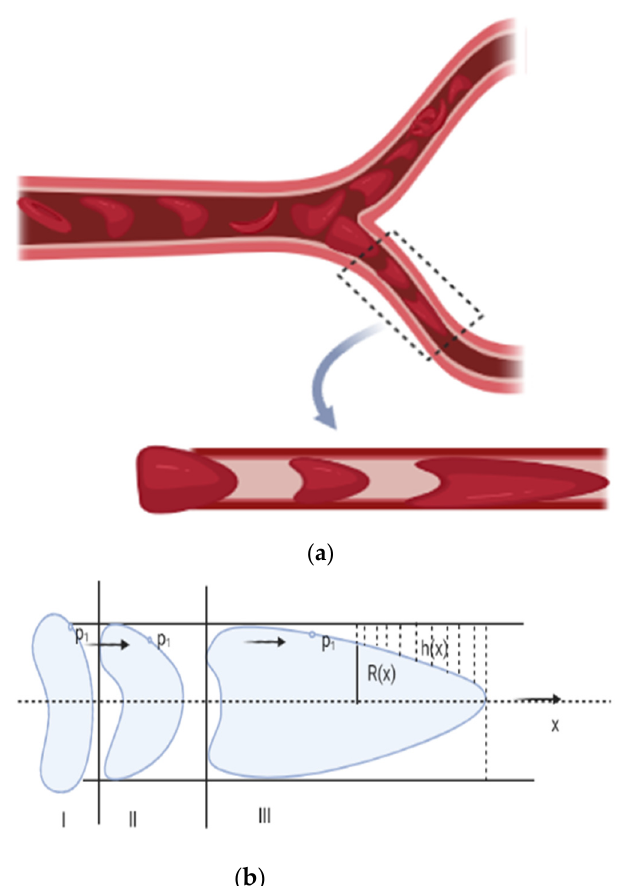
Figure 1. ( a ) Sickle Vaso-occlusion, ( b ) Geometrical Representation.